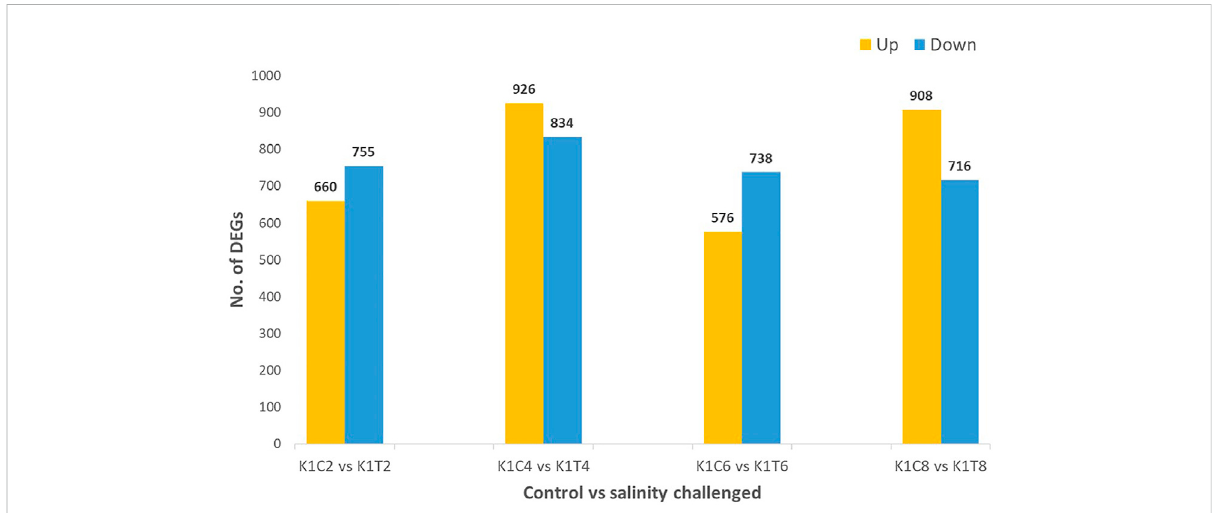
FIGURE 1 Differentially expressed (up- and downregulated) genes of the L. rohita kidney transcriptome at 2, 4, 6, and 8 ppt salinity concentrations (K1C2, K1C4, K1C6, and K1C8; and K1T2, K1T4, K1T6, and K1T8 are the control and salinity treatment groups at 2, 4, 6, and 8 ppt salt concentrations, respectively).